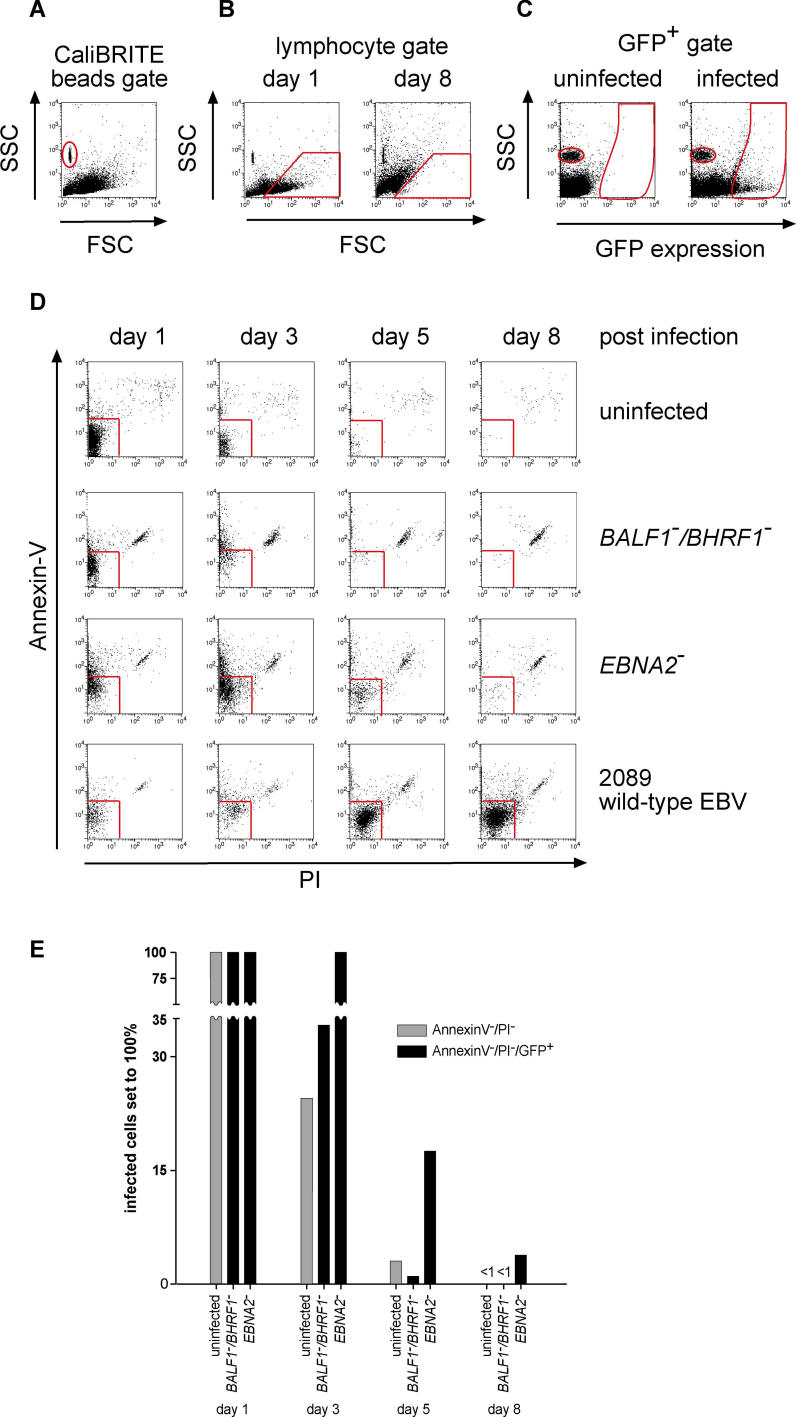
Apoptosis of Primary B CellsPrimary B cells were infected with the EBNA2− mutant 2491, the BALF1−/BHRF1− mutant 2636, or wild-type 2089 EBV, at an MOI of 0.1, or the cells were left uninfected. Cells were analyzed by FACS at days 1, 3, 5, and 8 p.i. (A) Total cellular events were collected until 3 × 103 BD CaliBRITE beads as a volume standard were counted. These beads, which are indicated by red circles in the FACS diagrams in (A) and (C), were used as an internal volume reference corresponding to 3 × 104 cells plated initially. (B) Uninfected cells that fulfilled the criteria of lymphocytes according to their forward (FSC) and sideward (SSC) scatter characteristics were gated as indicated. One day after B-cell preparation, lymphocytes were present in the lymphocyte gate as expected, but only a few lymphocytes were still present in this gate 8 d after cell preparation when the cells had been left uninfected. Similarly, EBV-infected lymphocytes were selected according to the same scatter criteria (data not shown). (C) EBV-infected GFP+ cells were gated as indicated. The example shows an uninfected and a 2491 EBNA2− EBV-infected B-cell sample with 3 × 103 BD CaliBRITE beads added 1 d p.i. (D) Uninfected primary B cells within the lymphocyte gate or EBV-infected GFP+ lymphocytes were analyzed by FACS for Annexin-V binding and PI staining at different time points p.i. The absolute numbers of Annexin-V−/PI−/GFP+ cells allowed the calculation of surviving cells at each time point p.i. Uninfected cells indicate the rate and kinetics of spontaneous apoptosis of primary B cells ex vivo. Primary B cells infected with the BALF1−/BHRF1− mutant 2636 died as rapidly as uninfected cells. Only B cells infected with the EBNA2− mutant 2491, which is vBcl-2+, survived considerably longer. Primary B cells infected with wild-type 2089 EBV as a positive control rapidly increased in the number of Annexin-V−/PI−/GFP+ cells. (E) Summary of the primary data shown in (D). Annexin-V−/PI− cells (uninfected control to determine spontaneous programmed cell death), or Annexin-V−/PI−/GFP+ (infected) cells were set to 100% at day 1, and the percentile of Annexin-V−/PI− cells at each time point was calculated. One representative experiment out of three is shown.